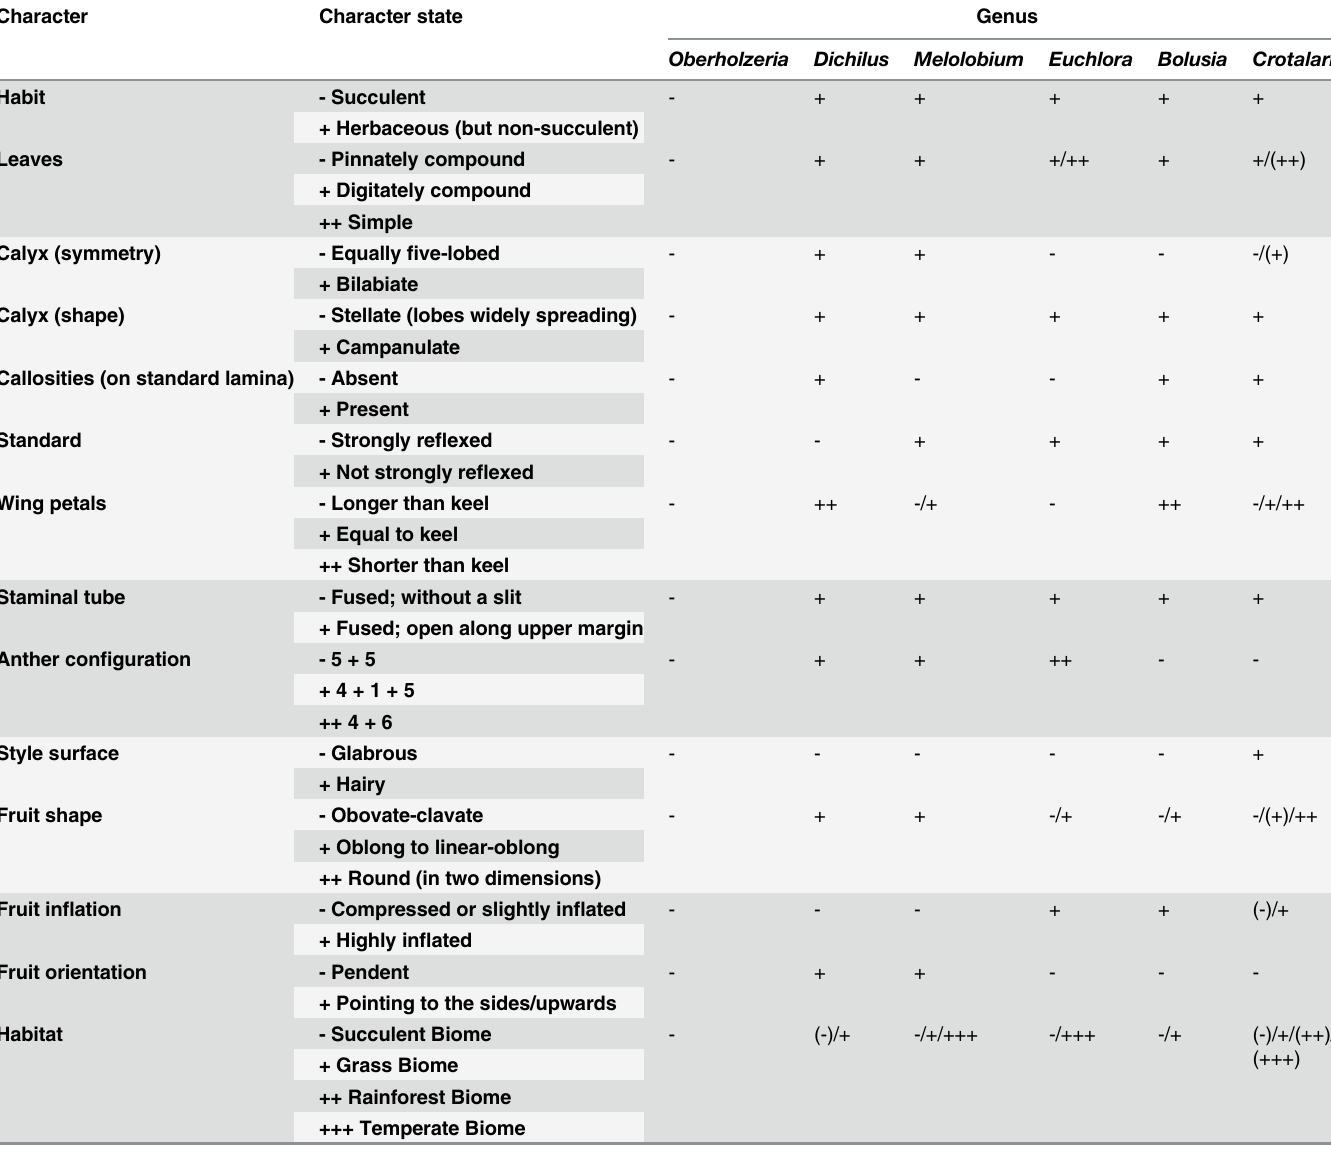
Table 2. Prominent differences between Oberholzeria and the early divergent genera from both the tribes Genisteae ( Dichilus and Melolobium ) and Crotalarieae ( Euchlora , Bolusia and Crotalaria